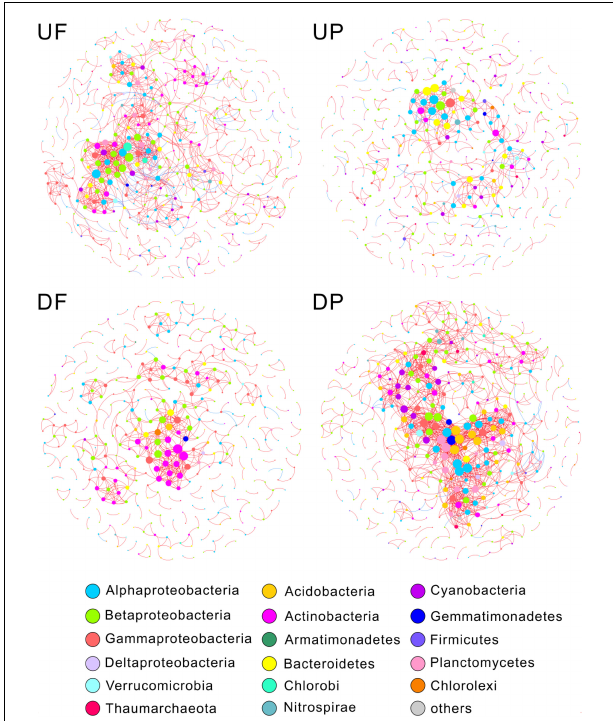
FIGURE 2 | Microorganisms with different lifestyles also differ in their response to the influence of the dam. Nodes are colored by phylogenetic phyla (class for Proteobacteria). Node sizes are proportional to degree. A red link indicates positive correlation, and a blue link indicates negative correlation. UF, free-living network for upstream; UP, particle-attached network for upstream; DF, free-living network for downstream; DP, particle-attached network for downstream.